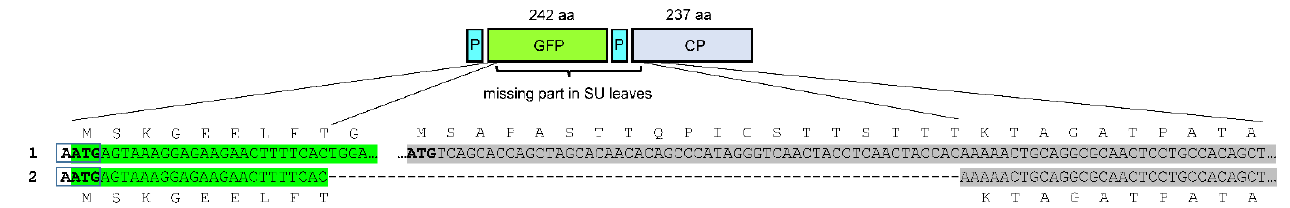
Figure 4. Alignment of the GFP/pGBX construct (1) and the RT-PCR GFP/pGBX product amplified from SU leaves at 21 dpi (2). The missing part (amino acids 9-242 of the GFP gene, PVX CP SGP, and the first 18 amino acids of PVX CP) is shown. The result of this deletion is the in-frame fusion of the first eight amino acids of GFP with the remainder of PVX CP. The ATG start codons of GFP and PVX CP are shown in bold, the GB barcode for the cloning of GFP is shown in frames. P, PVX CP subgenomic promoter.